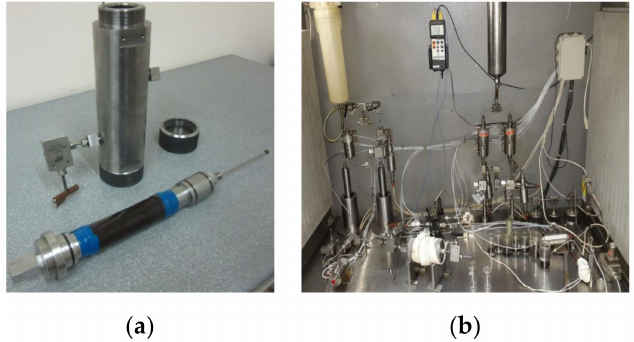
Figure 5. Hassler core holder ( a ) and core flooding setup ( b ) used in the present